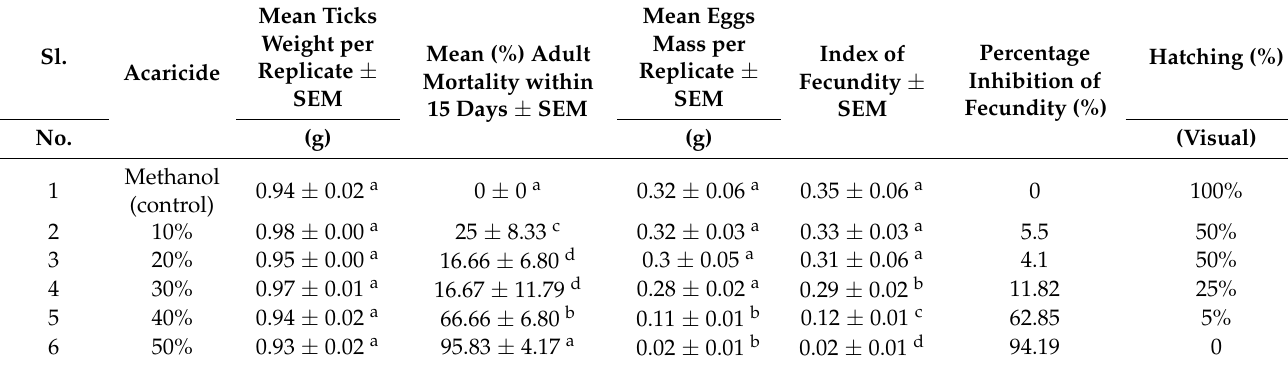
Table 2. Effect of terpenoid subfraction of hexane fraction of ethanolic extract of A. nilagirica against R. annulatus at different concentration.